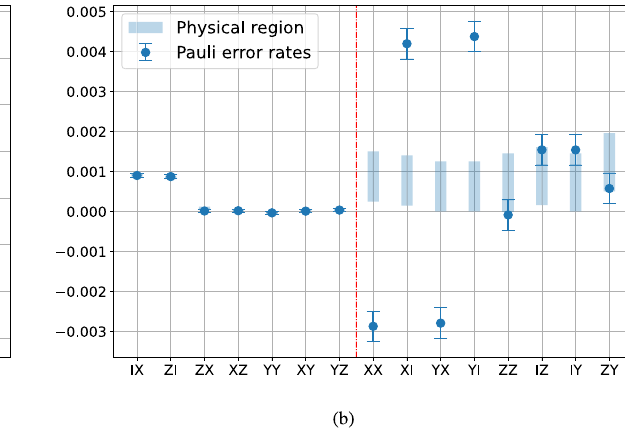
Foreachdepth C =150randomcircuitsand2000shotsofmeasurementsareused. Data are collected from ibmq_montreal on